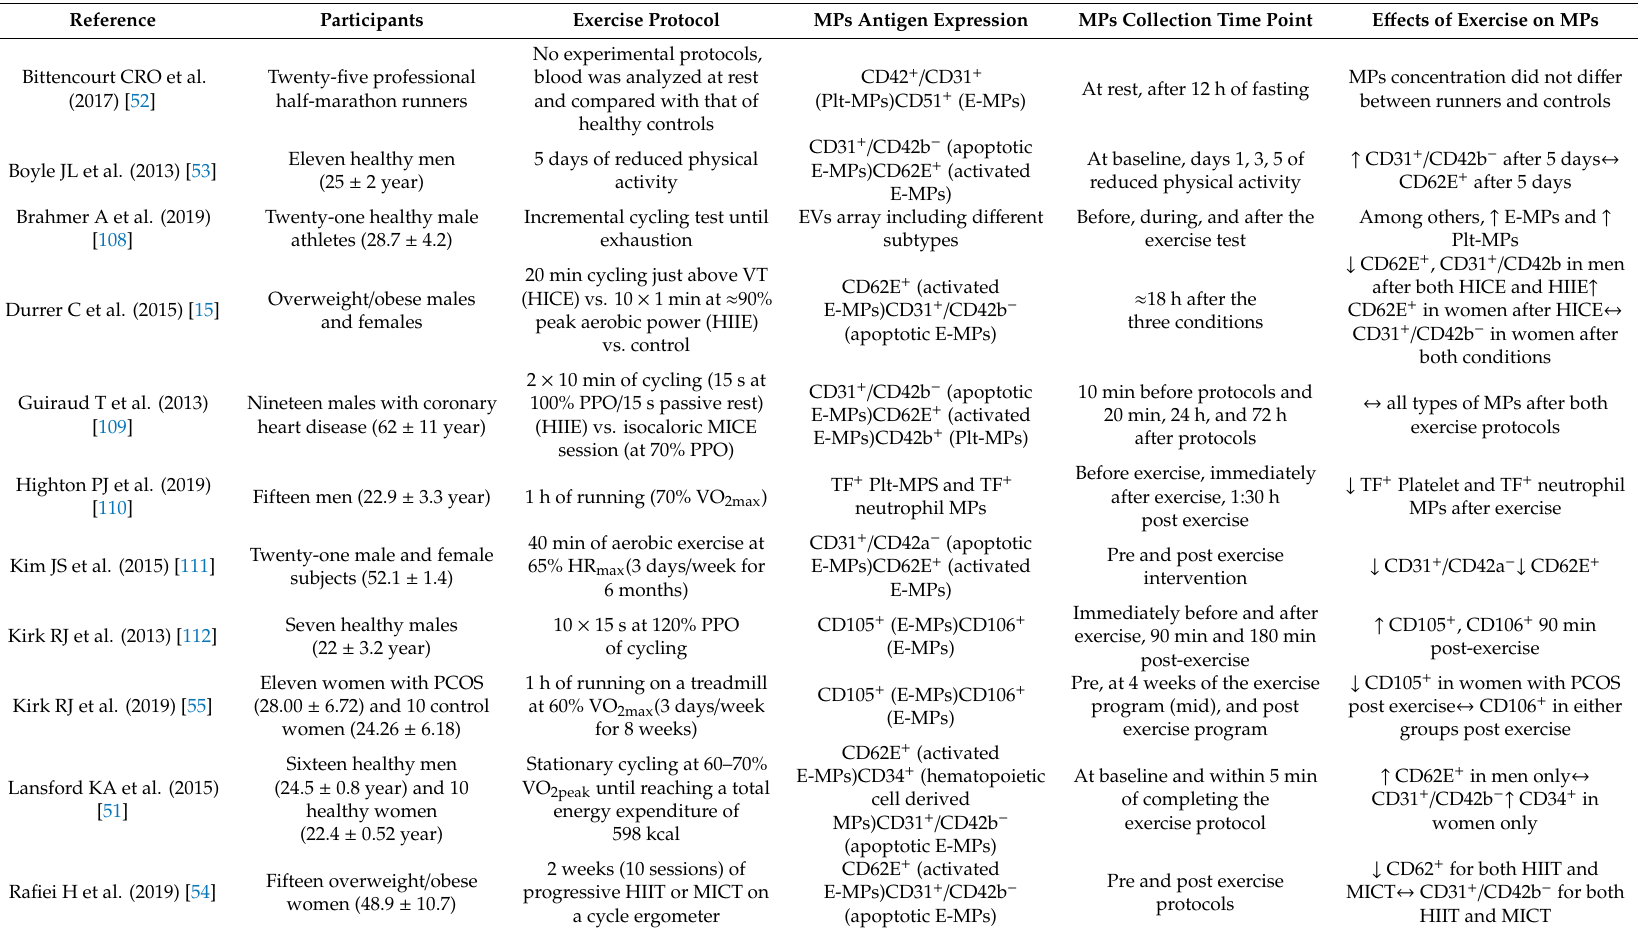
Table 2. Summary of studies that evaluate MPs concentration in relation with physical exercise / exercise training in various